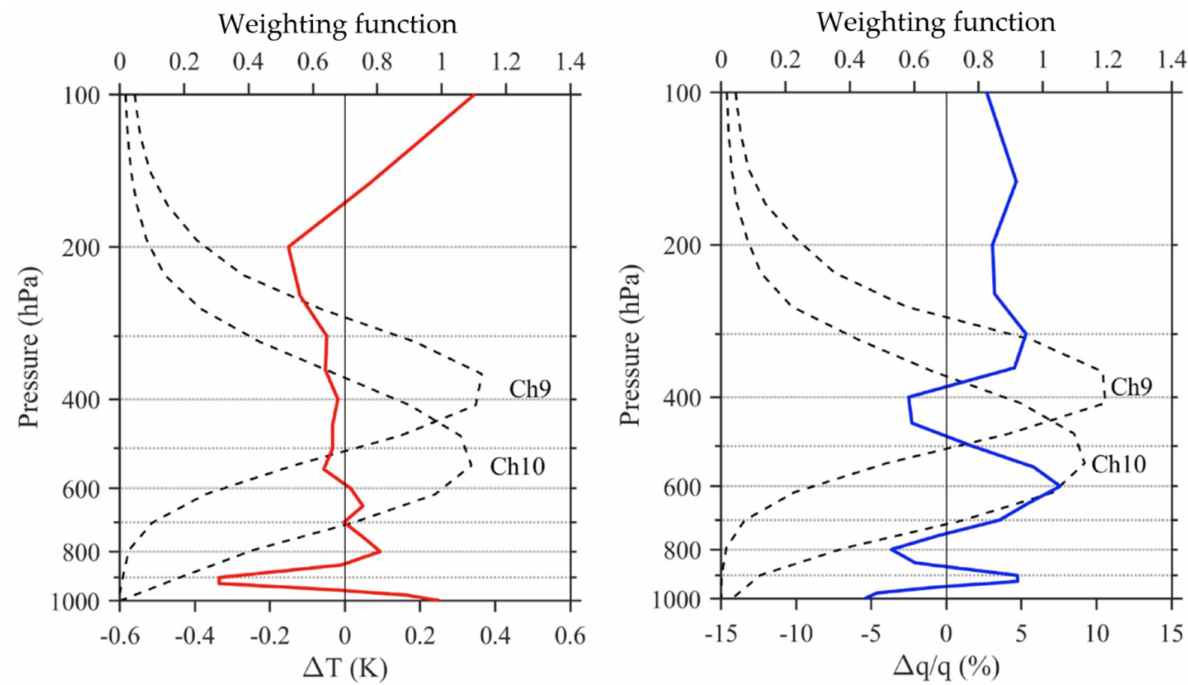
Figure 14. Vertical distributions of mean difference temperature ( ∆ T, left panel) and fractional differences of specific humidity ( ∆ q/q, right panel) between the FNL and ERA5 datasets (FNL minus ERA5) using clear–sky data over the ocean within the AGRI observing domain (zenith angle less than 60 ◦ ) at 0000, 0600, 1200, and 1800 UTC in January, April, July, and October 2019. The weighting functions for AGRI bands 9–10 are also shown (dashed